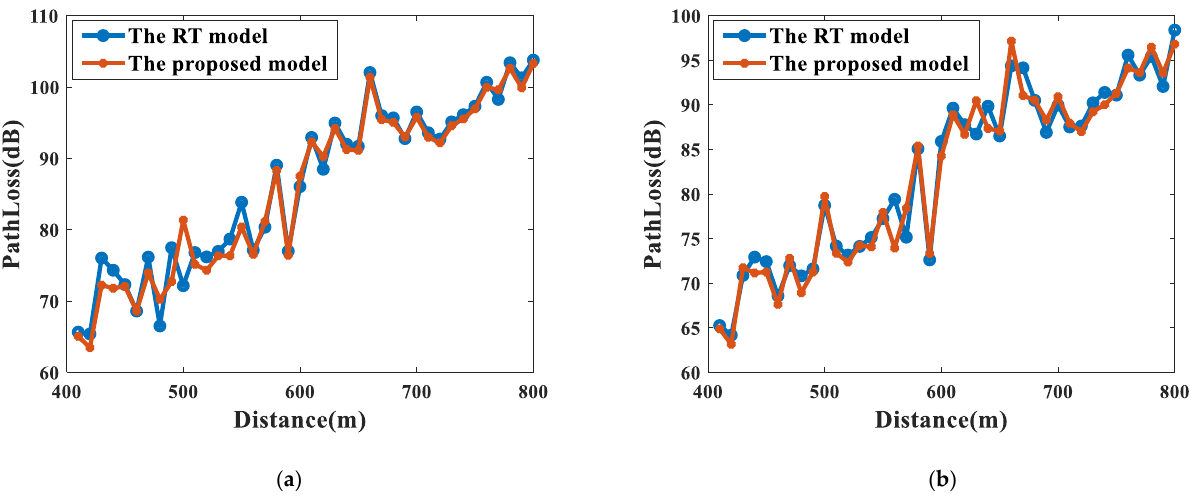
Figure 13. The comparison between the RT model in [32] and the proposed model at 3.5 GHz. ( a ) R = 500 m; ( b ) R = 1000 m.